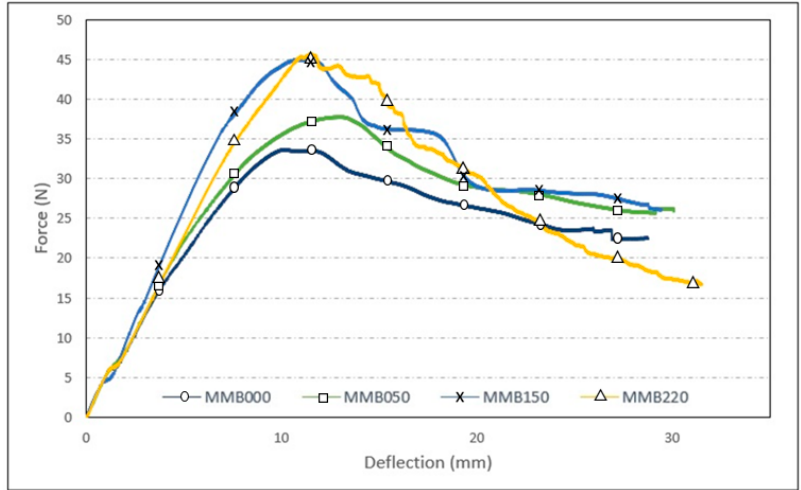
Figure 20. Force-Displacement comparison of different batches of GFRP in Mixed Mode I/II.